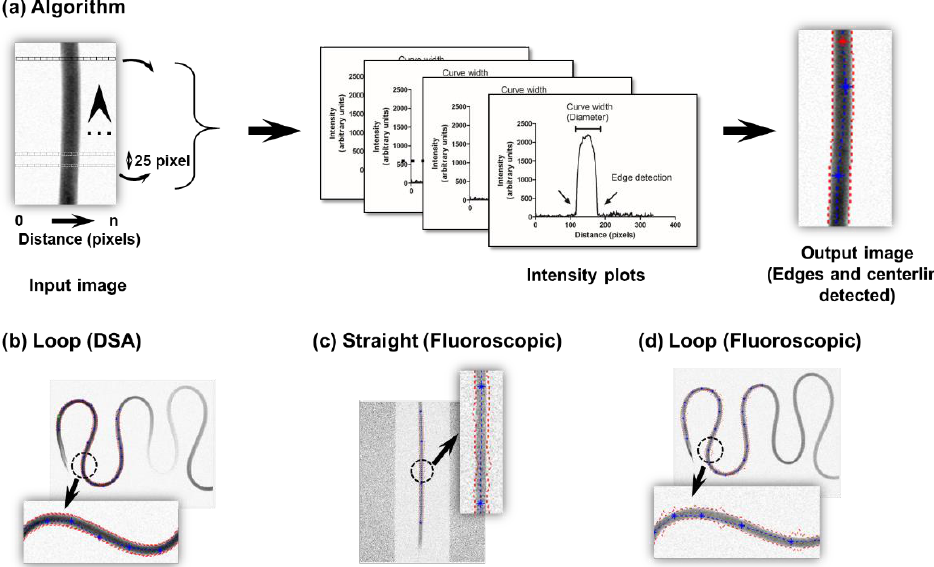
Figure 2. Edge detection method for area and distance calculation. ( a ) Algorithm elucidating the process of edge detection for an input image based on multiple distance-intensity plots obtained at discrete intervals (25 pixels) between the ROIs (up arrowhead indicates direction of fluid flow; dye propagation distance and edge detection are evaluated along this direction), ( b ) extracted edges, and the centerline based on a loop configuration for DSA acquisition. For fluoroscopic imaging, the extracted edges and centerline are based on a ( c ) straight tube, or ( d ) loop configuration. Dotted red lines indicate edges, and dotted blue lines indicate centerline (zoomed image in inset).